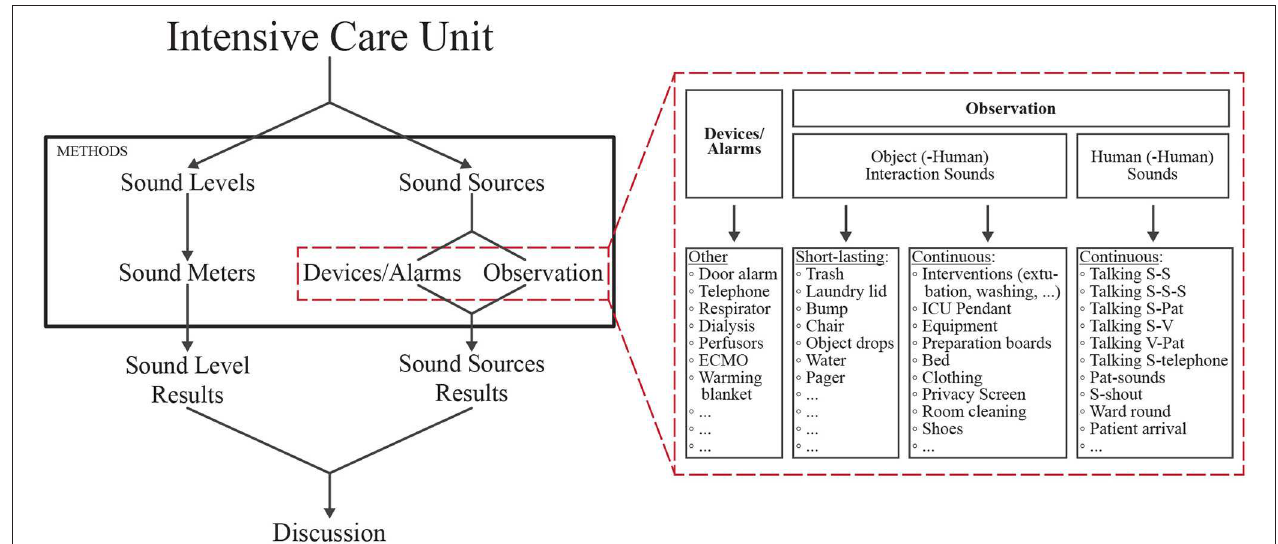
FIGURE 1 | Schematic outlining the two parallel methods for examining sound in the ICU setting. Left: The sound pressure levels in the ICU can be determined objectively using sound level meters. Right (red dashed box): details showing how the sound sources in the ICU can be determined via device alarms or via observers. These two components of sound in the ICU can be combined to create an overall picture of sound in the ICU. Staff (S); patient (Pat); visitor (V); extracorporeal membrane oxygenation (ECMO); intensive care unit (ICU). Full list of abbreviations, sound sources and descriptions can be found in the Supplementary Table 1